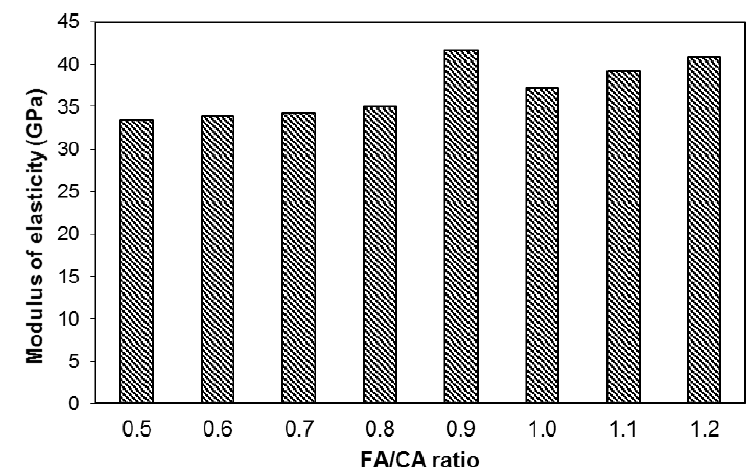
Figure 10. Modulus of Elasticity at 28 days of SFRC, with different FA/CA ratios.